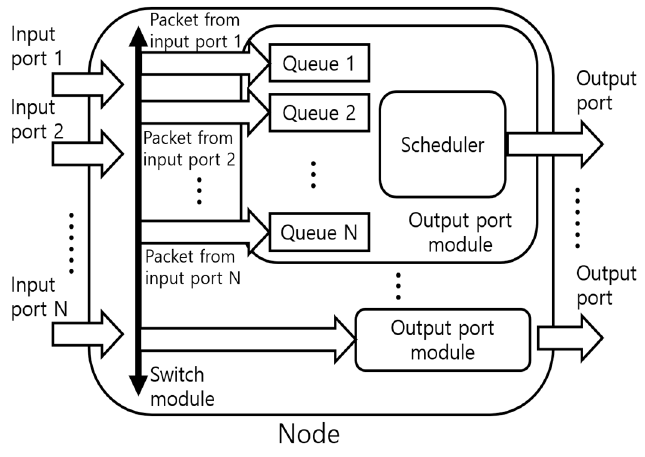
Figure 1. Node architecture used in the simulation.